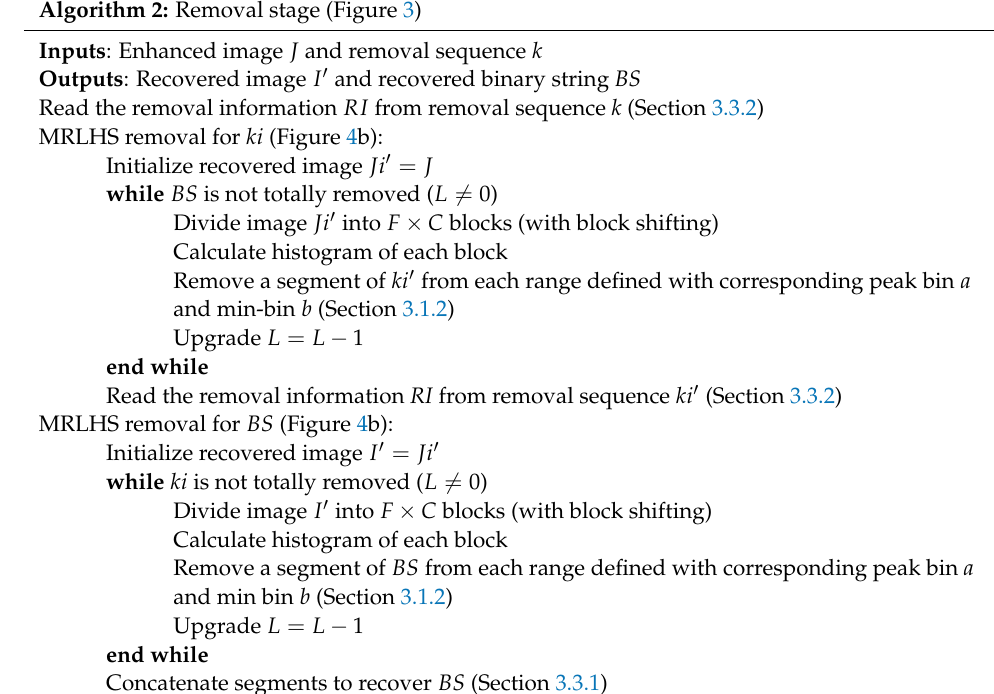
Algorithm 2: Removal stage (Figure